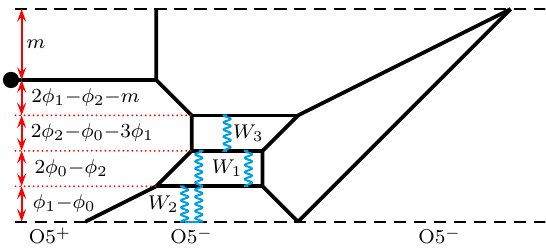
Figure 11. A 5-brane web for 6d G 2 gauge theory with one